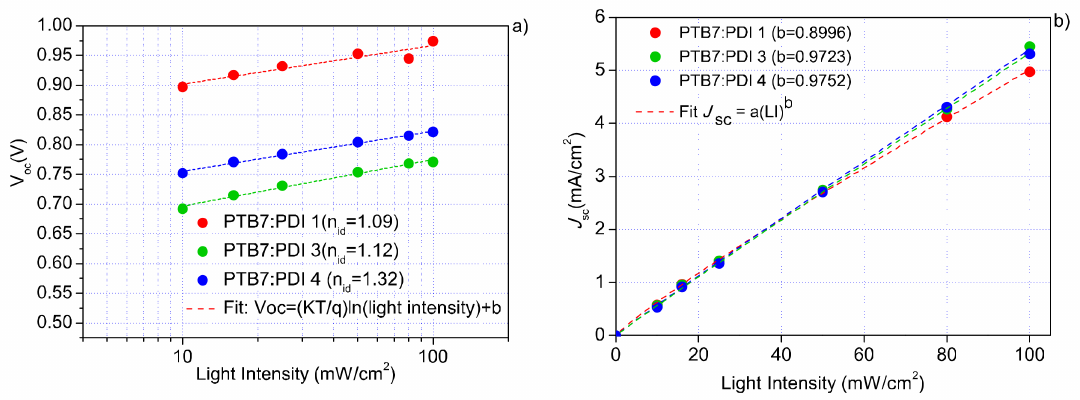
Figure 6. ( a ) Open circuit voltage vs. light intensity plot for all PDIs; ( b ) Short circuit current density vs. light intensity plot for all